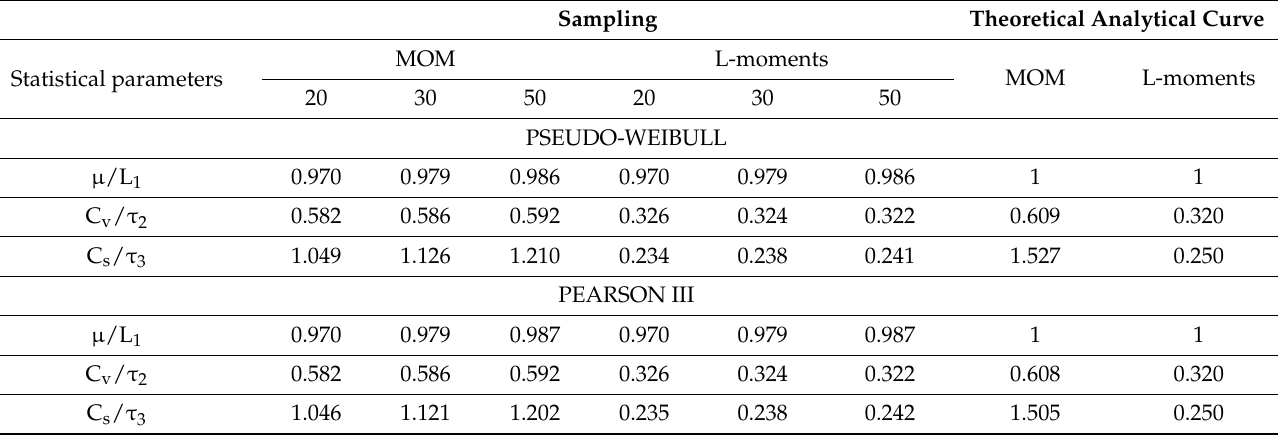
Table 3. Theoretical curve sampling